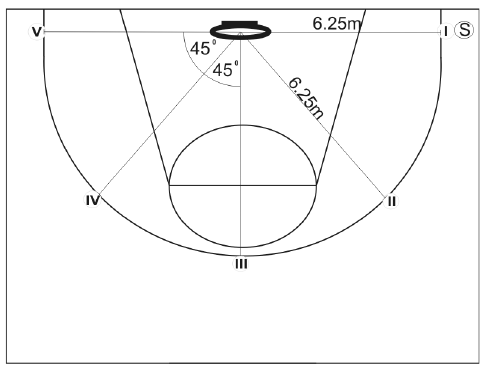
Figure 4. The stationary three-point shooting test (S3P) Legend. S = shooter/testee.